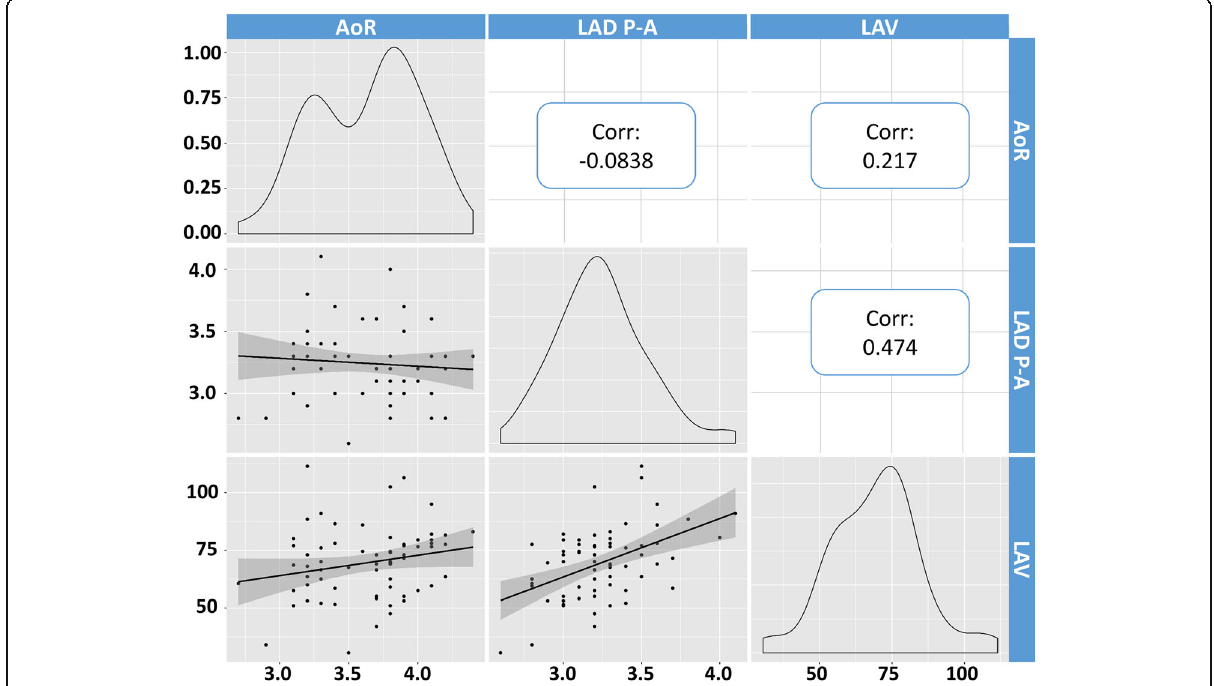
Fig. 1 AoR, LAD P-A, and LAV data were tested for distribution and correlation. Data distribution is shown in the oblique quadrants. AoR appears to have a bimodal distribution with a pit at around 3.5 cm. LAD P-A has a unimodal distribution with a peak around 3.5 cm. LAV has a slight bimodal distribution with a pit around 65 ml (left shoulder of the highest peak). AoR showed poor correlation with LAD P-A and LAV. LAV correlation with LAD P-A results in r = 0.474 demonstrating a scarce degree of the two elements to vary together. The slope of the fitted lines and their 95% CI (gray/shade zone) are also